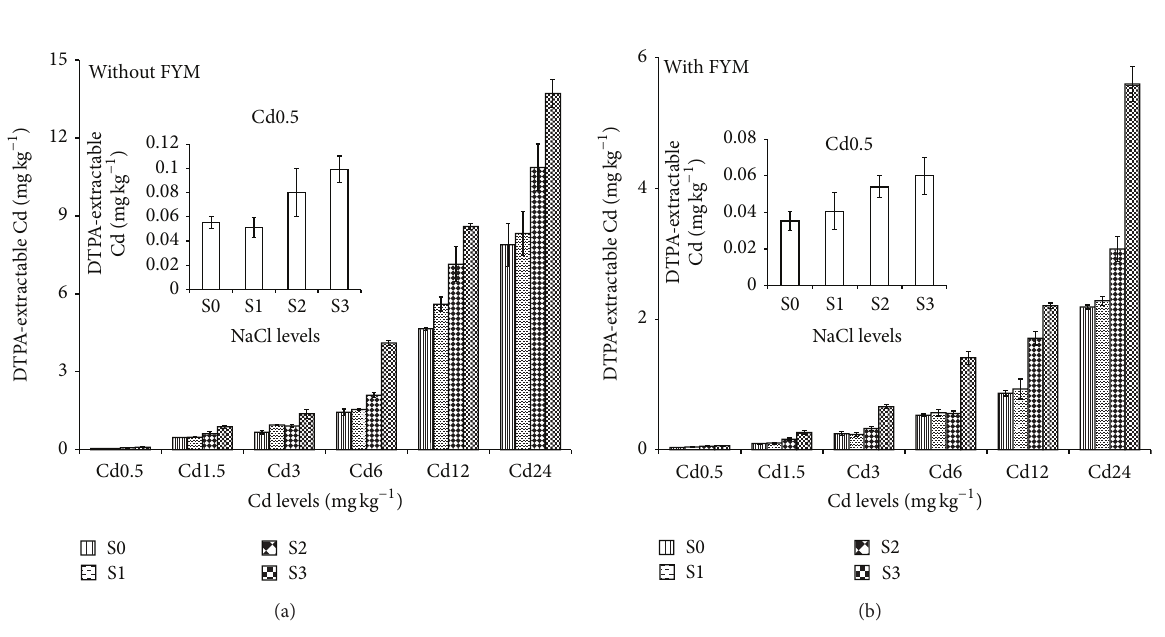
Figure 1: Treatment effects on DTPA-extractable Cd ( ±